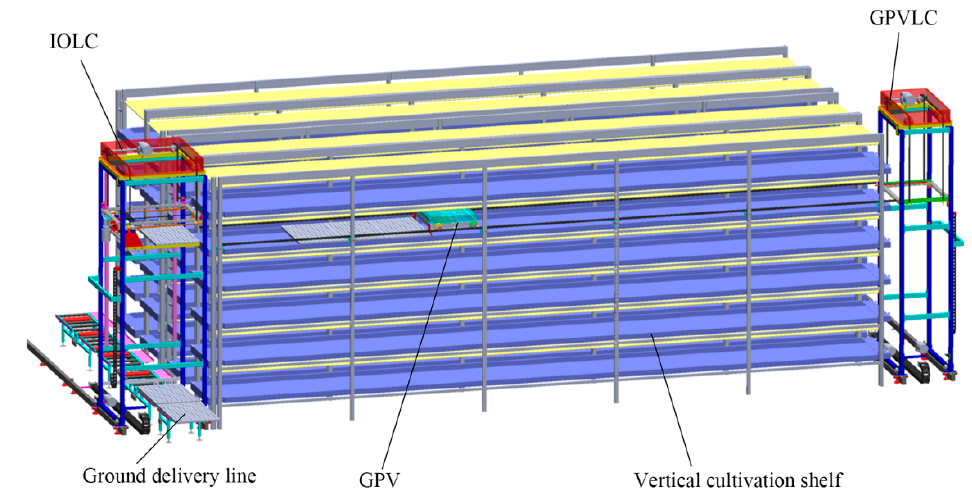
Figure 4. Vertical transport system of cultivation units without power inside shelf.